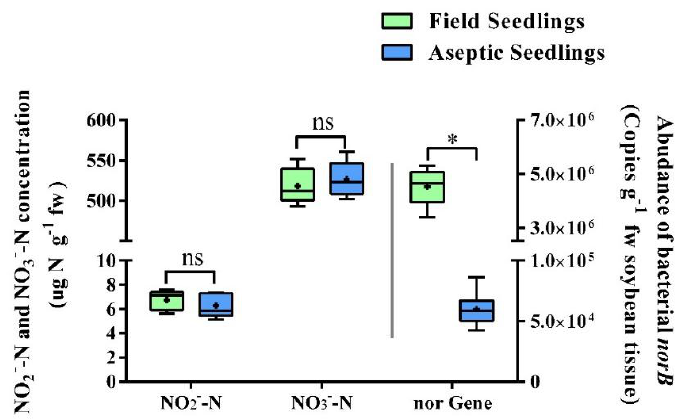
Figure 3. NO 2 -N, NO 3− -N and norB gene concentration in field or aseptic soybean seedlings. Error bar indicates the SD. Asterisk indicates high significant differences from the field seedlings only in nor gene abundance ( t -test, * p < 0.05, ns = not significant).